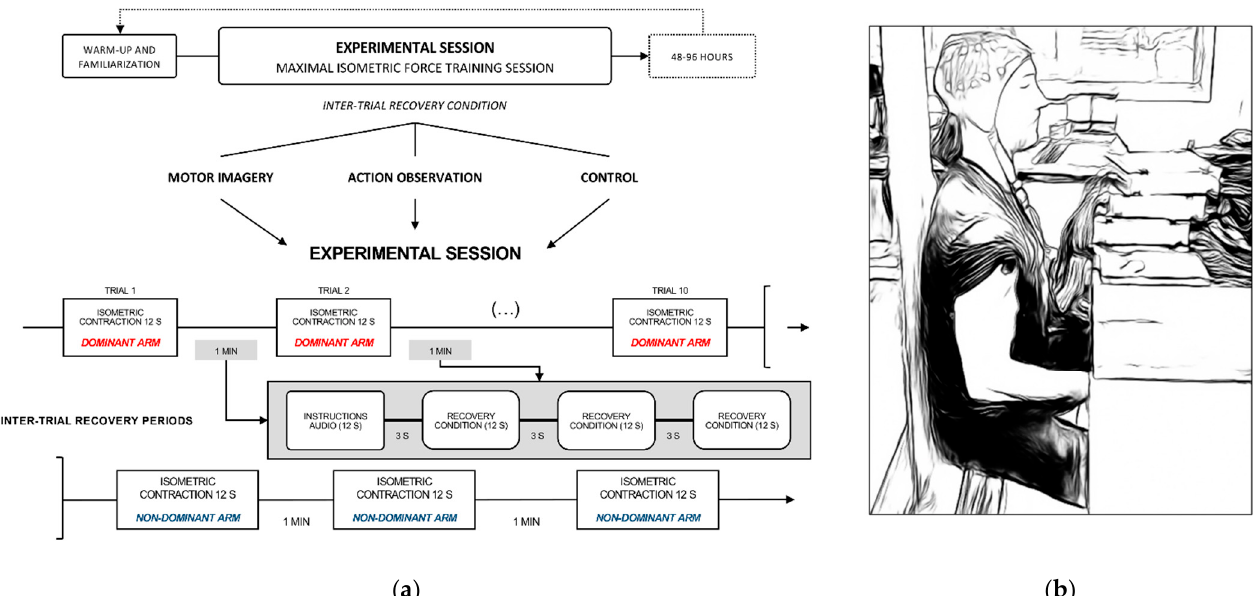
Figure 1. Schematic representation of the experimental design. ( a ) Flowchart depicting the factorial plan of the within-subjects experimental design, which included three experimental sessions. Participants first completed warm-up force trials, followed by a familiarization to the experimental condition of the day. Next, they underwent a strength training session consisting in 10 maximal isometric force trials sustained for 12 s, with 1 min inter-trial rest periods allocated to recovery. Each experimental session involved one of the three possible inter-trials recovery condition (i.e., control, motor imagery and action observation), administered in a counterbalanced order across participants. Each experimental session involved a total of 13 maximal isometric contractions (i.e., 10 with the dominant arm, 3 with the non-dominant arm), sustained for 12 s each; ( b ) standardized body position in front of a fixed force platform, against which participants produced a maximal voluntary contraction, with the elbow at 90° (i.e., vertical arrow).